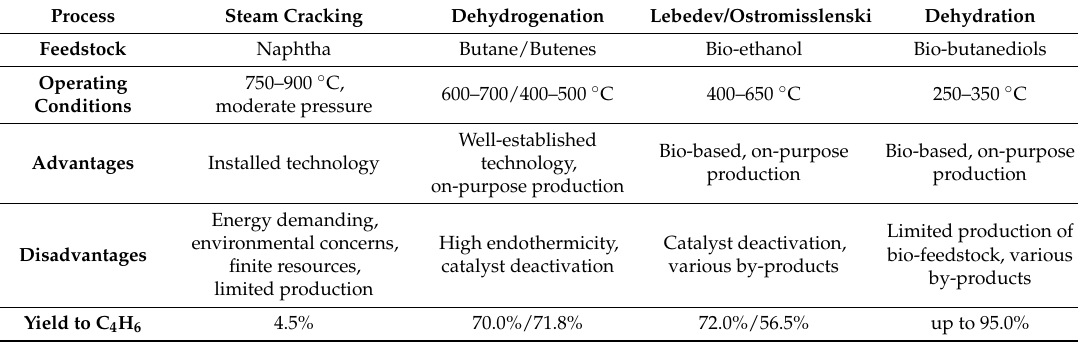
Table 5. Comparison of C 4 H 6 production